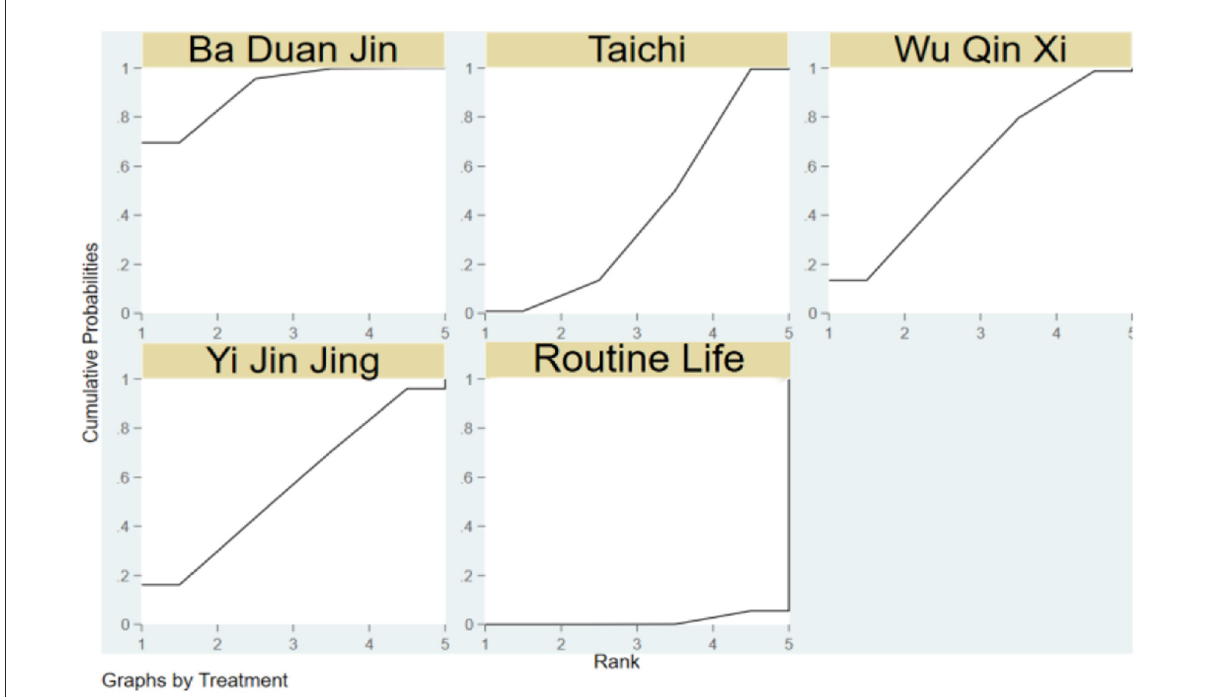
FIGURE4 Cumulative probability SUCRA plots of the effects of different traditional programs on TUGT in the elderly.